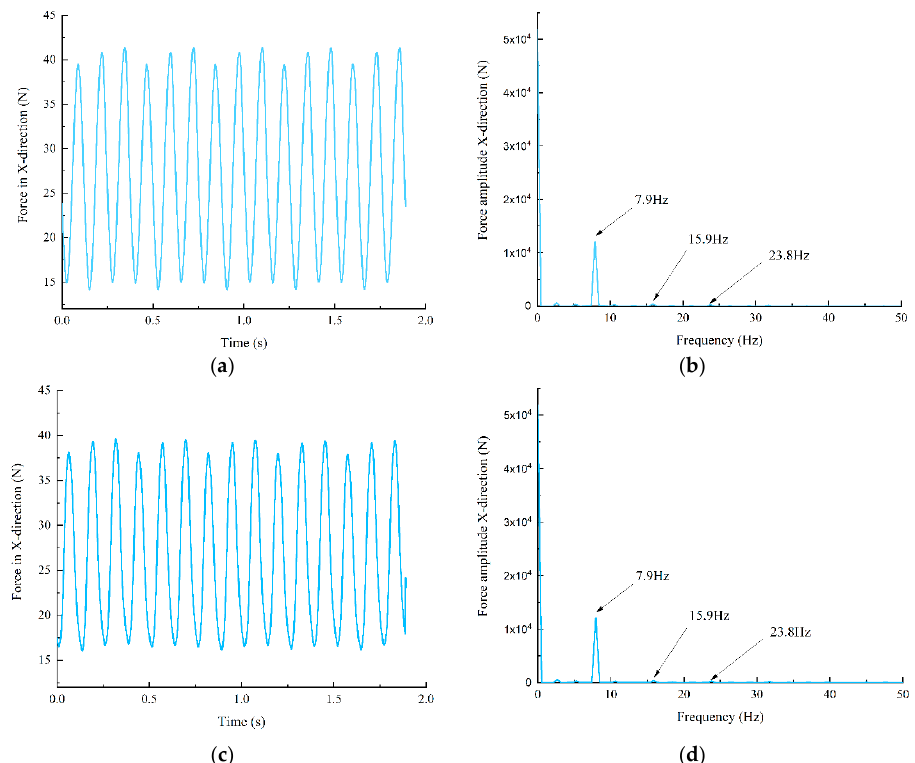
Figure 19. Aerodynamic loads acting on blades of the ( a ) H ‐ type and ( c ) hybrid VAWTs in the X ‐ direction and their dominant excitation frequencies for the ( b ) H ‐ type and ( d ) hybrid VAWTs.